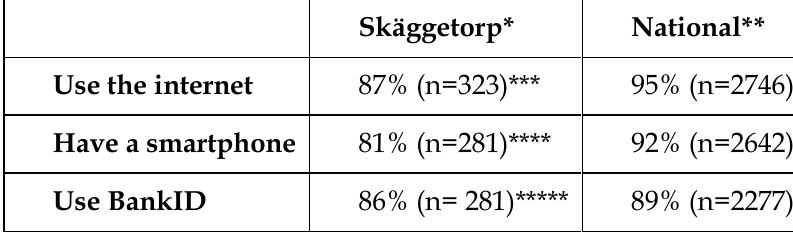
Table 1. Access to and usage of internet, smartphone and BankID.